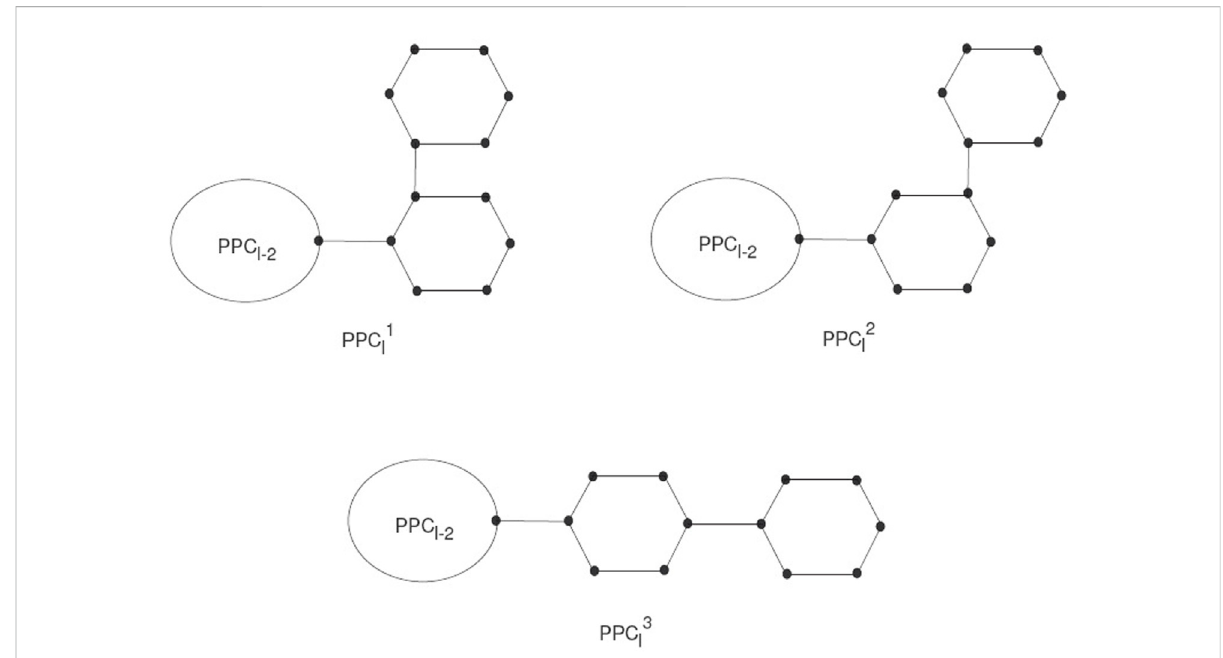
FIGURE 3 The three types of local arrangements of hexagons PPC 1 l , PPC 2 l , and PPC 3 l